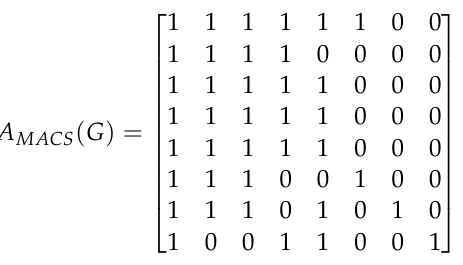
Figure 9. The MACS graph of human movements within the 8 macro-districts. The obtained adjacency matrix of the graph is determined.